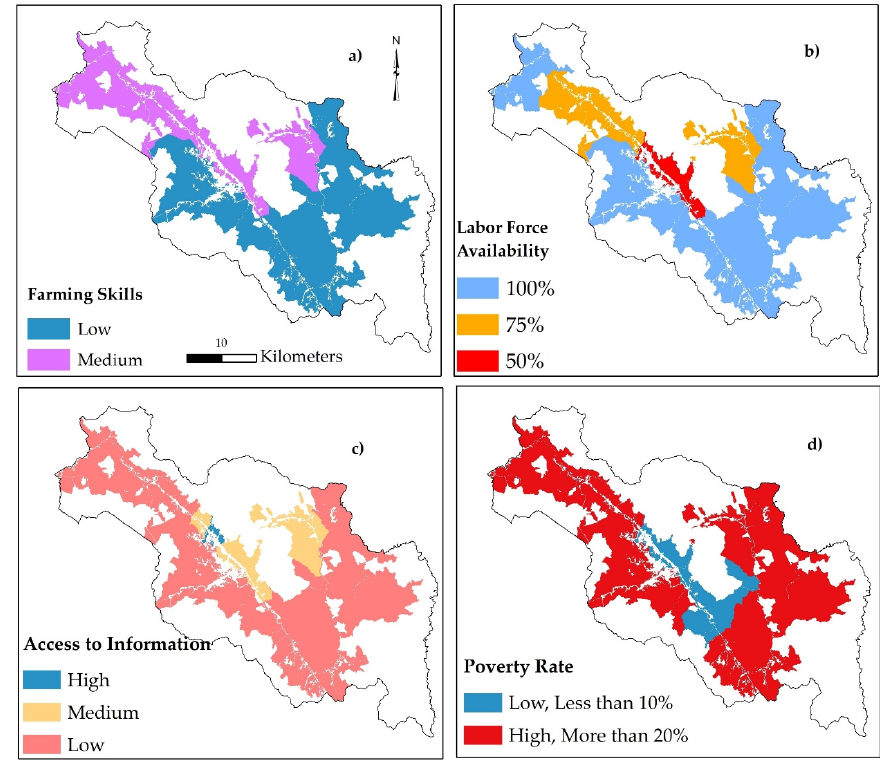
Figure 6. Geographic distribution of social criteria in A Luoi district: ( a ) level of faming skills; ( b ) labor force availability; ( c ) access to information; and, ( d ) poverty rate.